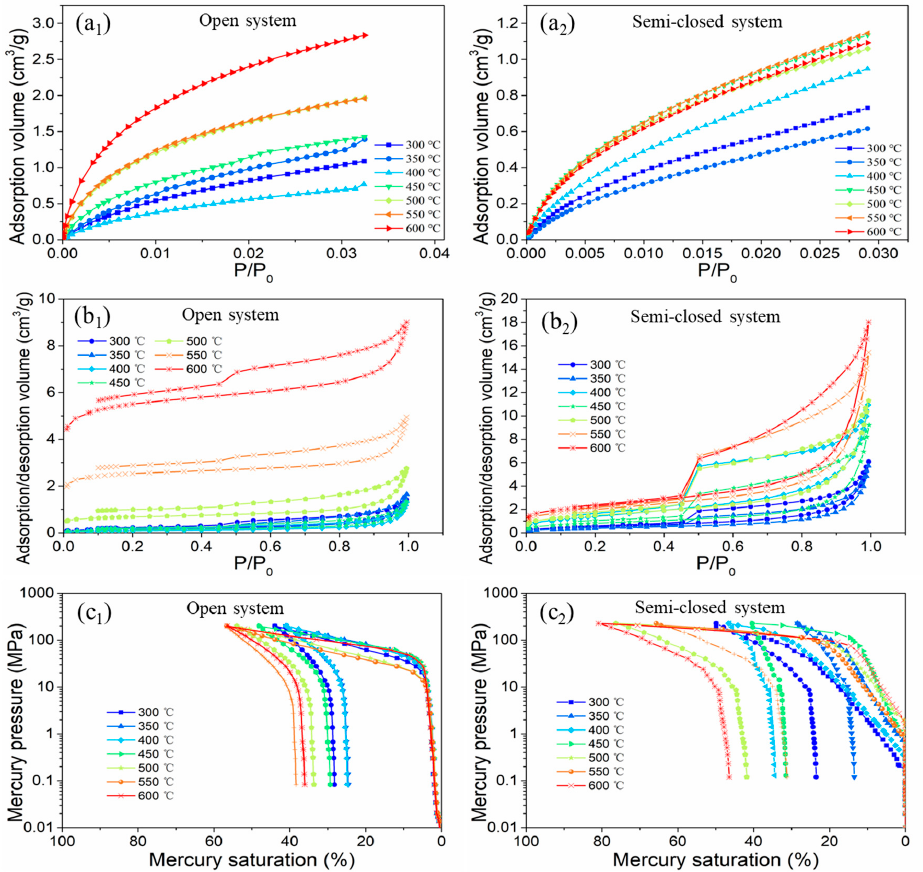
Figure 7. ( a1, a2 ) CO 2 adsorption isotherms, ( b1, b2 ) N 2 adsorption/desorption isotherms, and ( c1, c2 ) MIP curves from the two pyrolysis experiments. Data of semi-closed pyrolysis are cited from Fang et al. [21].